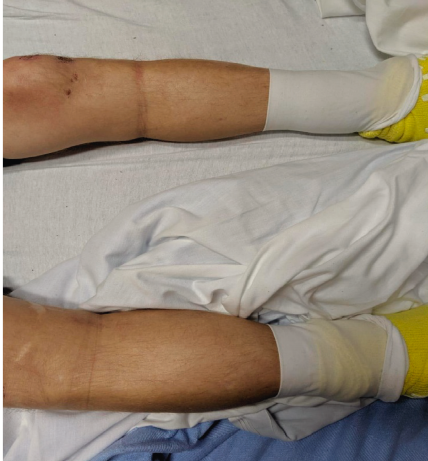
Figure 1: Bilateral pedal edema to the level of the knees secondary to insulin therapy (photograph was taken with patient’s